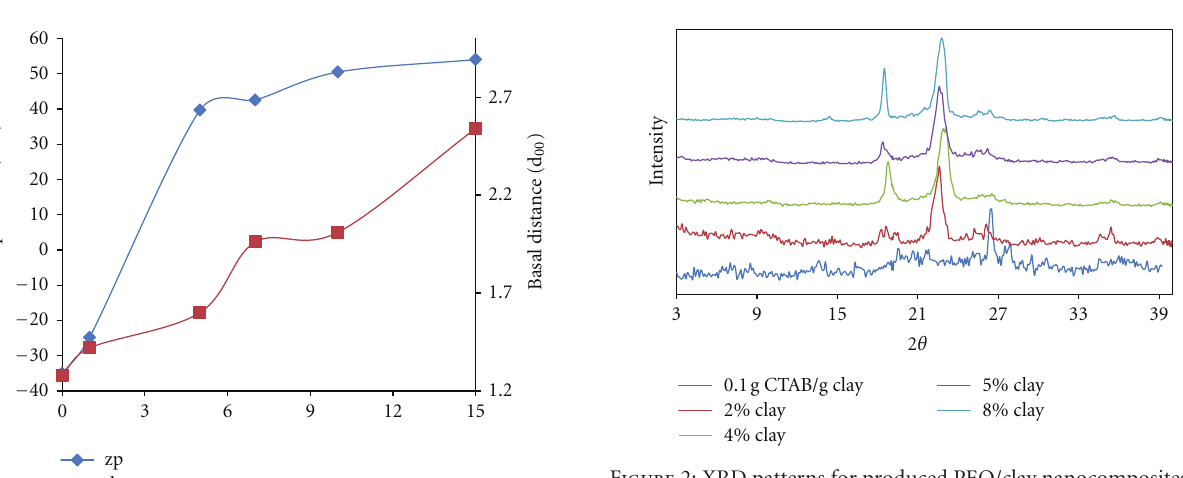
Figure 2: XRD patterns for produced PEO/clay nanocomposites at various clay compositions (0.1 g CTAB/g clay